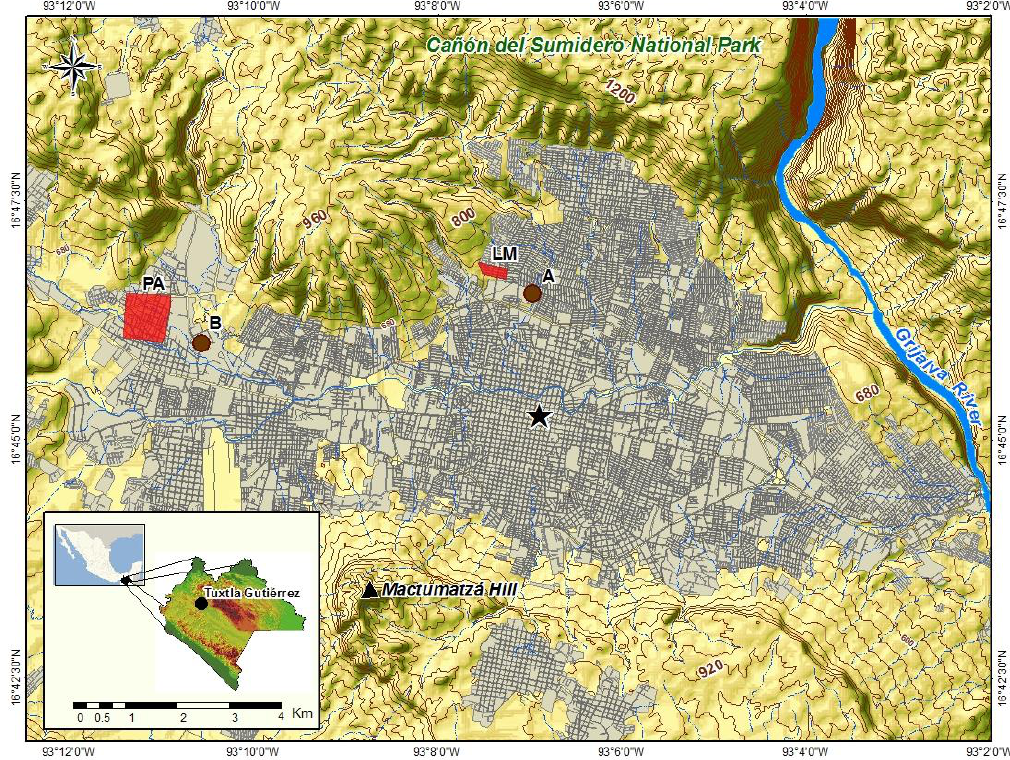
Figure 1. Sites selected in Tuxtla Gutiérrez (TGZ) to quantify emissions from unpaved roads are represented by red polygons and refer to Lajas Maciel (LM) and Plan de Ayala (PA). A and B represents points for monitoring PM 10 concentration. The central part of the city is represented by . The blue lines represent the presence of rivers and streams. The brown slight lines represent elevation in meters above sea level.